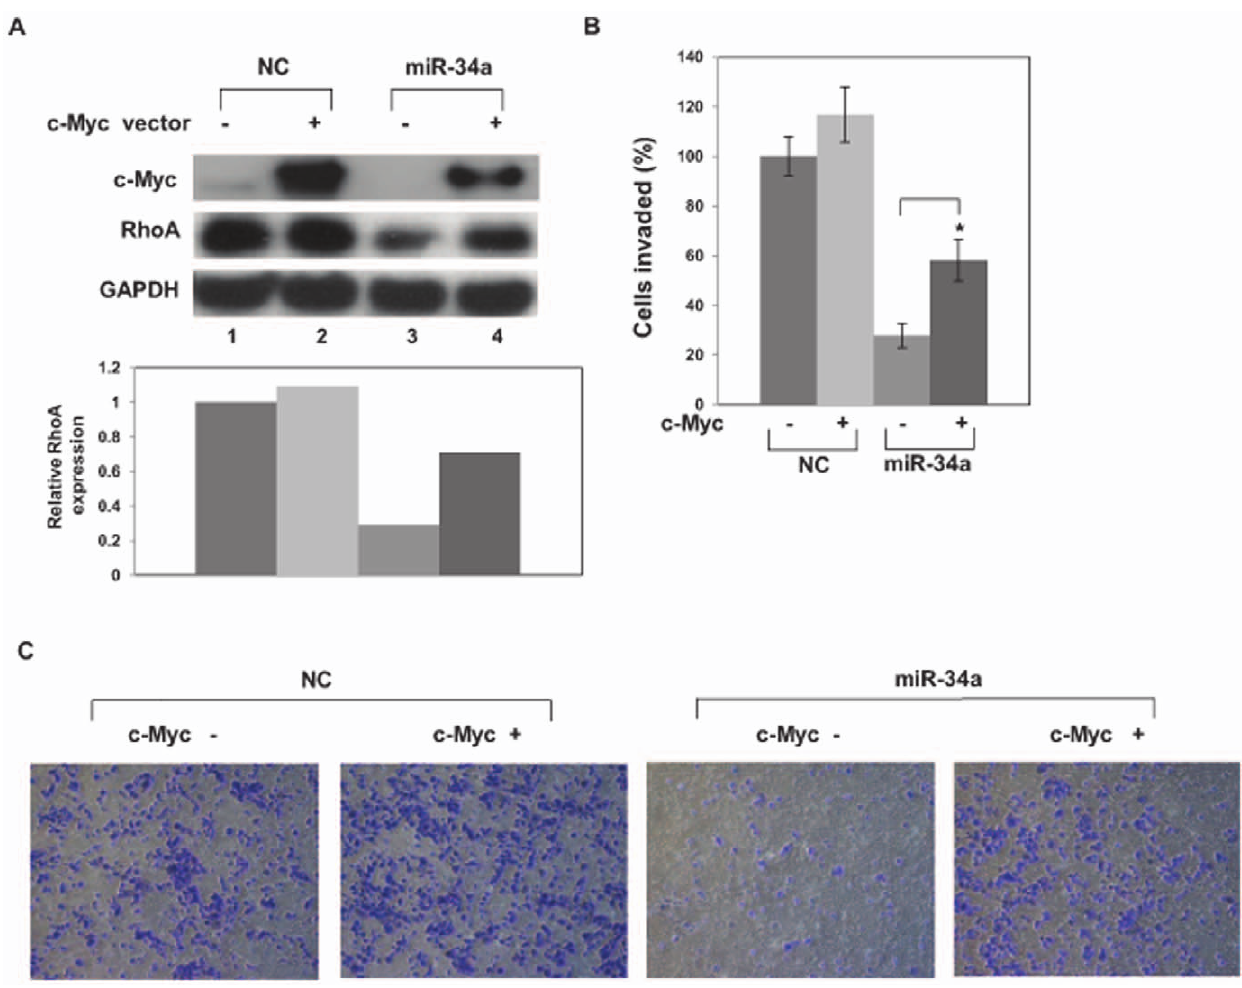
Figure 5. c-Myc overexpression partially rescues RhoA suppression by miR-34a. (A) PC-3 cells were transiently transfected with pCMV6- ENTRY only or pCMV6-ENTRY-c-Myc for 8 h followed by transient transfection with pre-miR negative control (NC) or pre–miR-34a for 72 h. Protein level was analyzed by Western blot. (B) c-Myc expression partially rescues inhibition of invasion induced by miR-34a. PC3 cells were transiently transfected with pCMV6-ENTRY only (control) or pCMV6-ENTRY-c-Myc for 8 h followed by transfection with pre-miR negative control (NC) or pre–miR- 34a for 48 h. The cells were harvested and subjected to transwell invasion assay. *, P , 0.05 compared with control. (C) Representative images of invaded